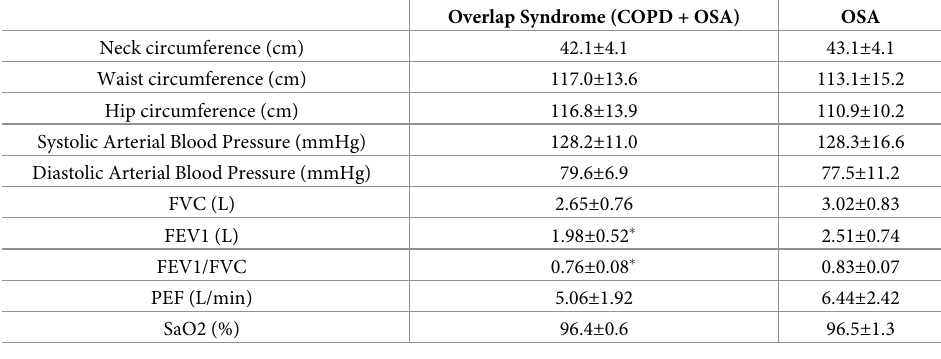
Table 4. Characteristics of the study groups (mean±SD) after 3 months of